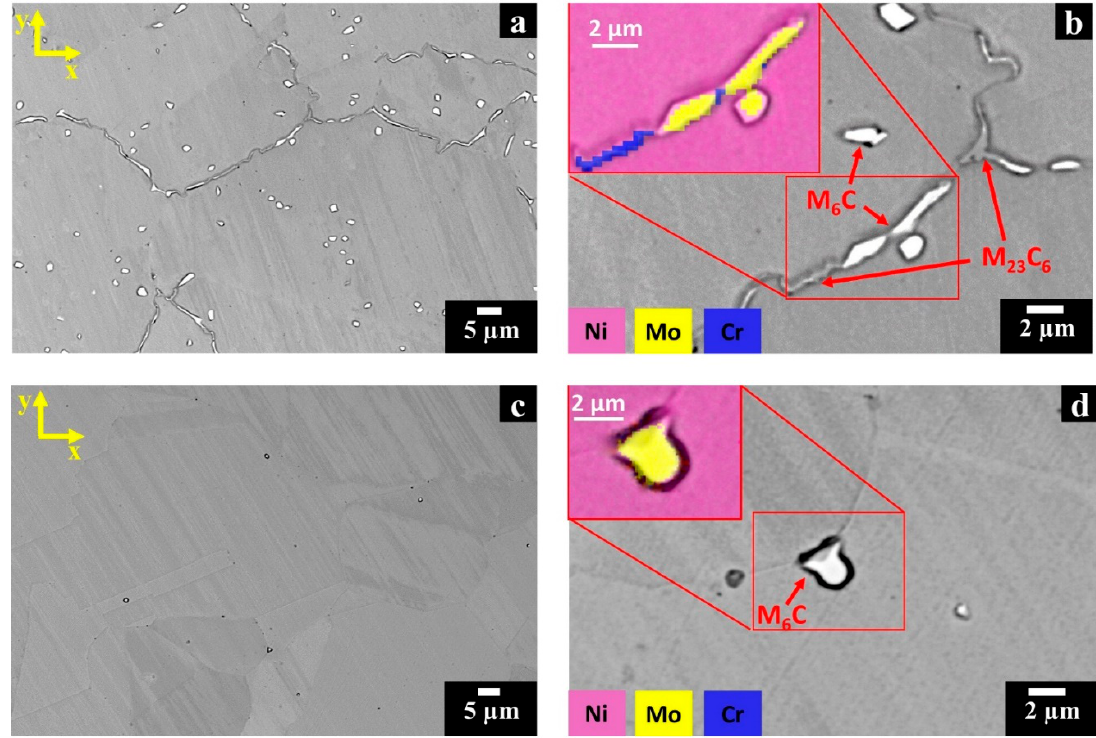
Figure 4. BSE SEM micrographs of post-processed HX samples along the x-y plane: ( a , b ) HIPed HX samples with an energy dispersive X-ray spectrometry (EDS) map showing the presence of Mo-rich M 6 C and Cr-rich M 23 C 6 carbides; ( c , d ) post-solution annealed HX samples with an EDS map showing Mo-rich M 6 C carbides. Kalling’s No.2 etchant was used.